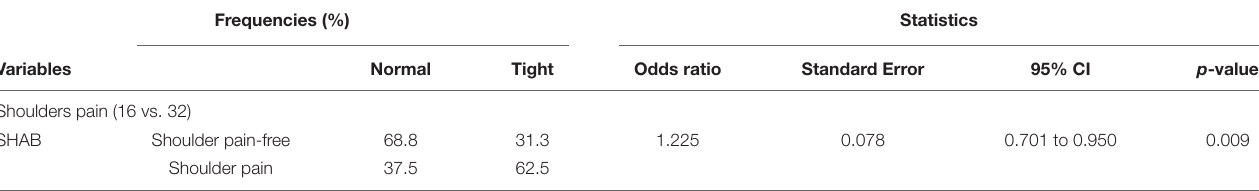
TABLE 3 | Frequencies and logistical regression results: intrinsic risk factors for shoulder pain in 24 young swimmers ( n = 48).